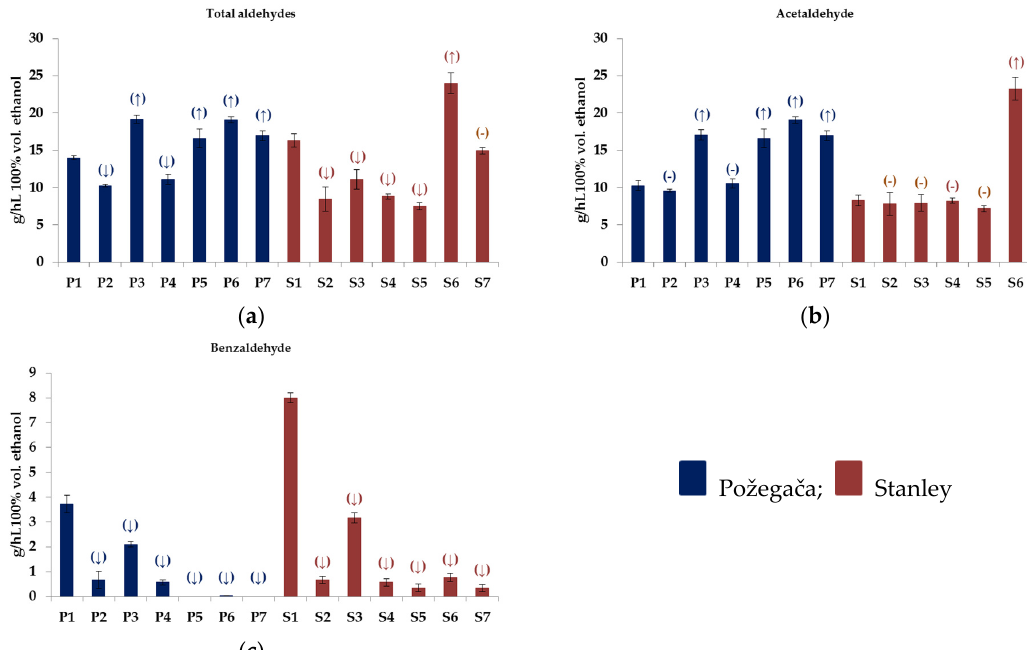
Figure 4. Content of aldehydes (g/hL 100% vol. ethanol) in plum spirits of Požegaˇca (P) and Stanley (S) varieties produced by traditional method (P1 and S1) and modified methods (P2–P7 and S2–S7): ( a ) TAd, ( b ) Ad1, and ( c ) Ad2. (Codes are listed in Table S1 of Supplementary Materials.) For each plum variety, different marks indicate differences in the means ( p < 0.05), according to Dunnett test: ( ↑ ) Statistically significant higher values compared to values in traditionally produced plum spirit, ( ↓ ): Statistically significant lower values compared to values in traditionally produced plum spirit, (-): No statistically significant differences in values compared to values in traditionally produced plum spirit. Concentrations of all parameters are shown as mean ± standard